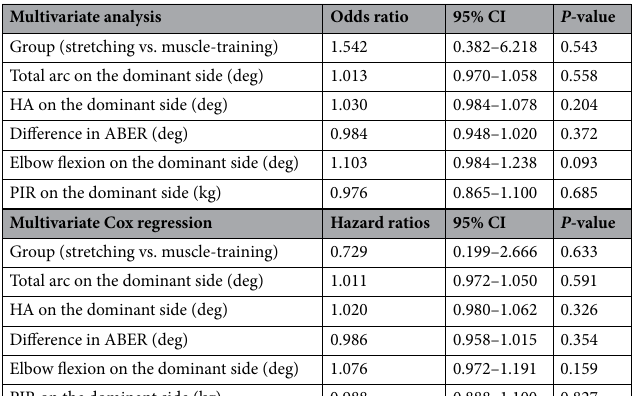
Multivariate analysis Odds ratio 95% CI P